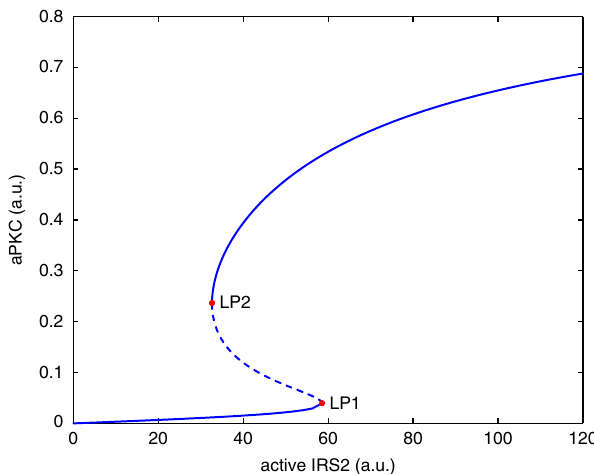
Fig. 3 Bifurcation diagram of the aPKC sub-system with the level of active IRS2 as control parameter. The broken line between the two marked limit points (LP1 and LP2) denotes unstable steady